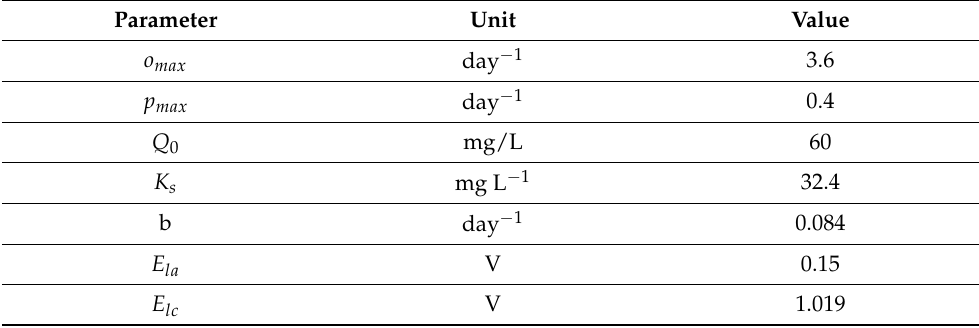
Table 1. The values of main